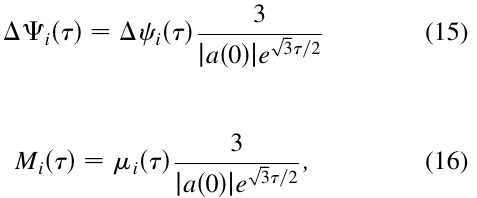
(cid:2) 0 (cid:4) (cid:3) i